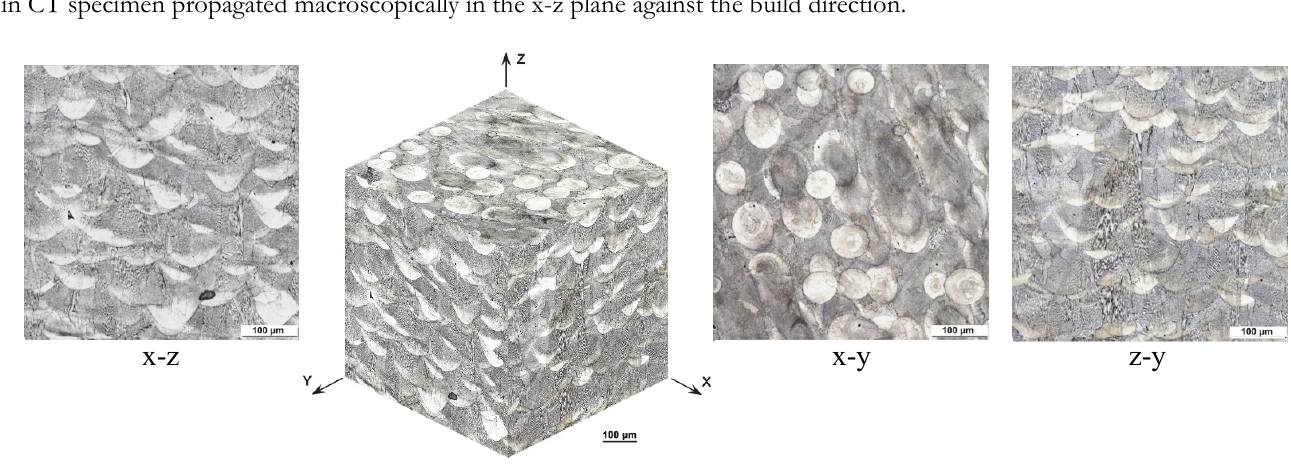
Figure 5: Layered structure of SLM Inconel 718,